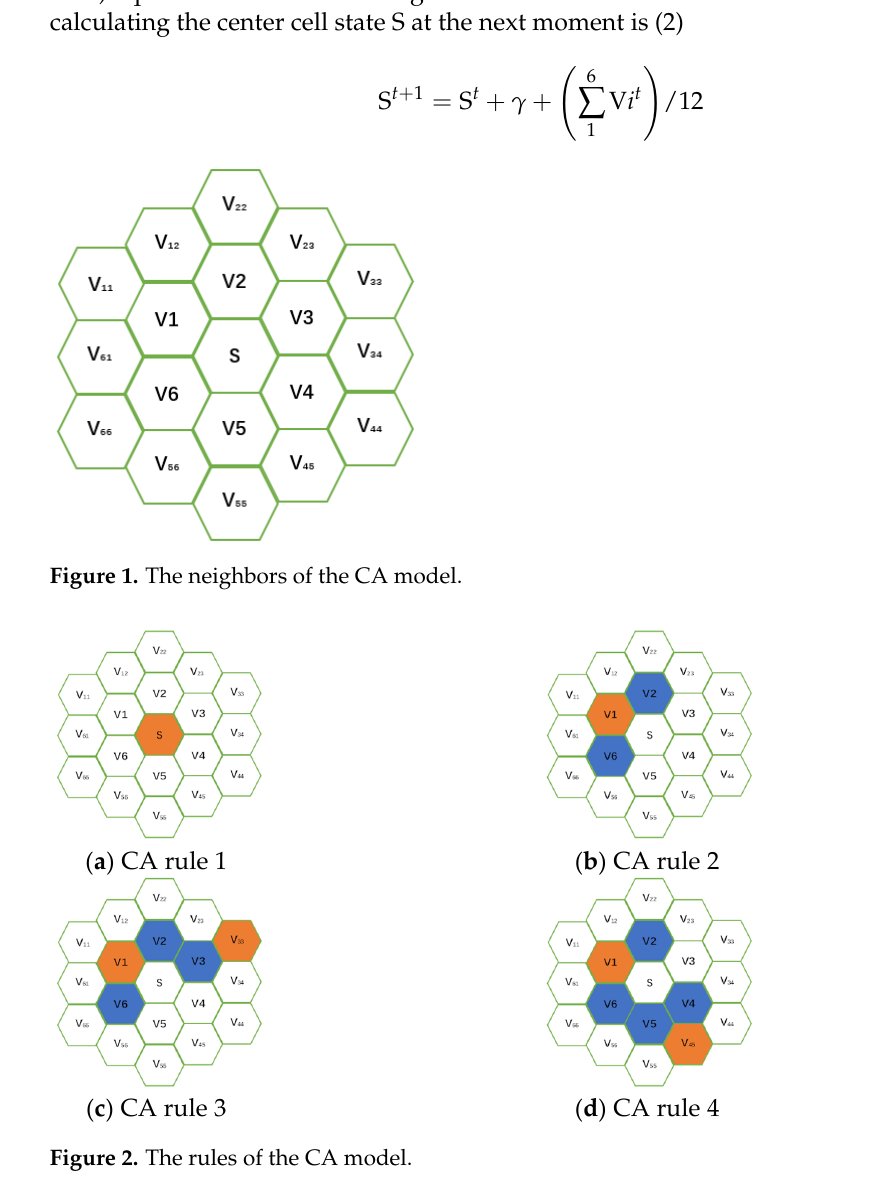
Figure 2. The rules of the CA model.